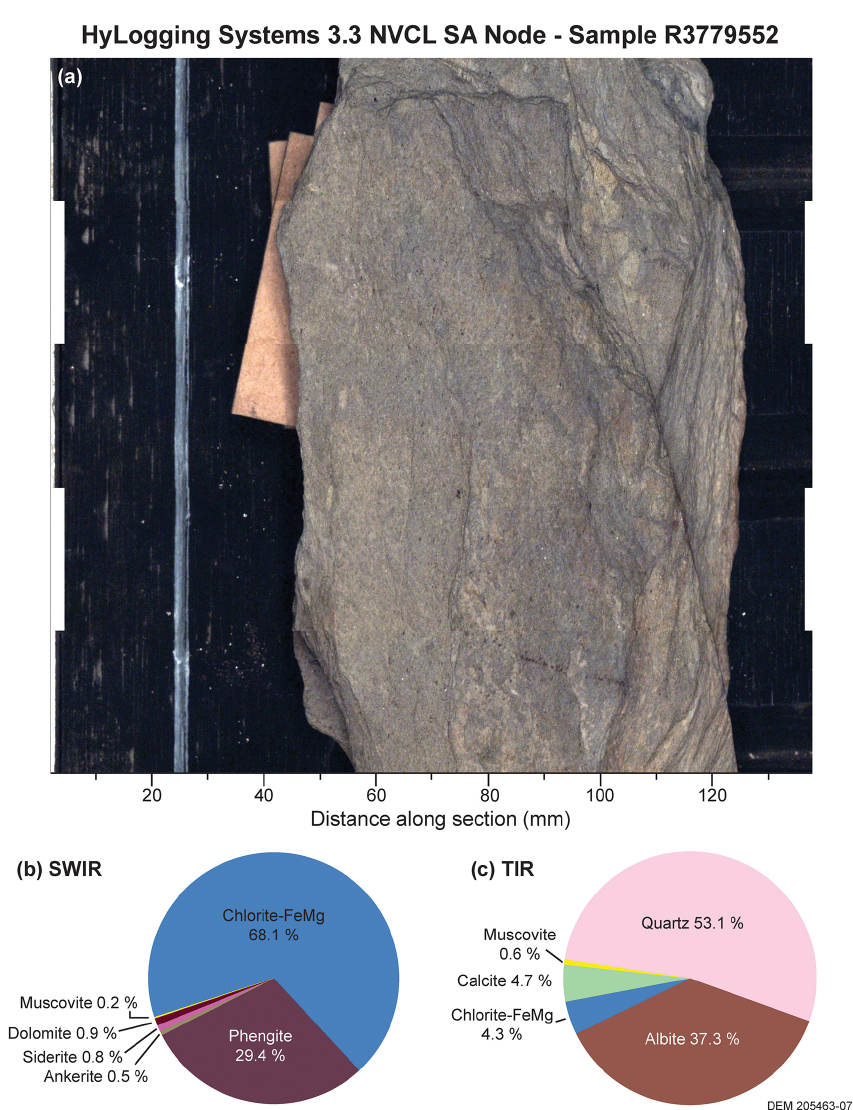
Figure A3. Hyperspectral mineralogy results for sample